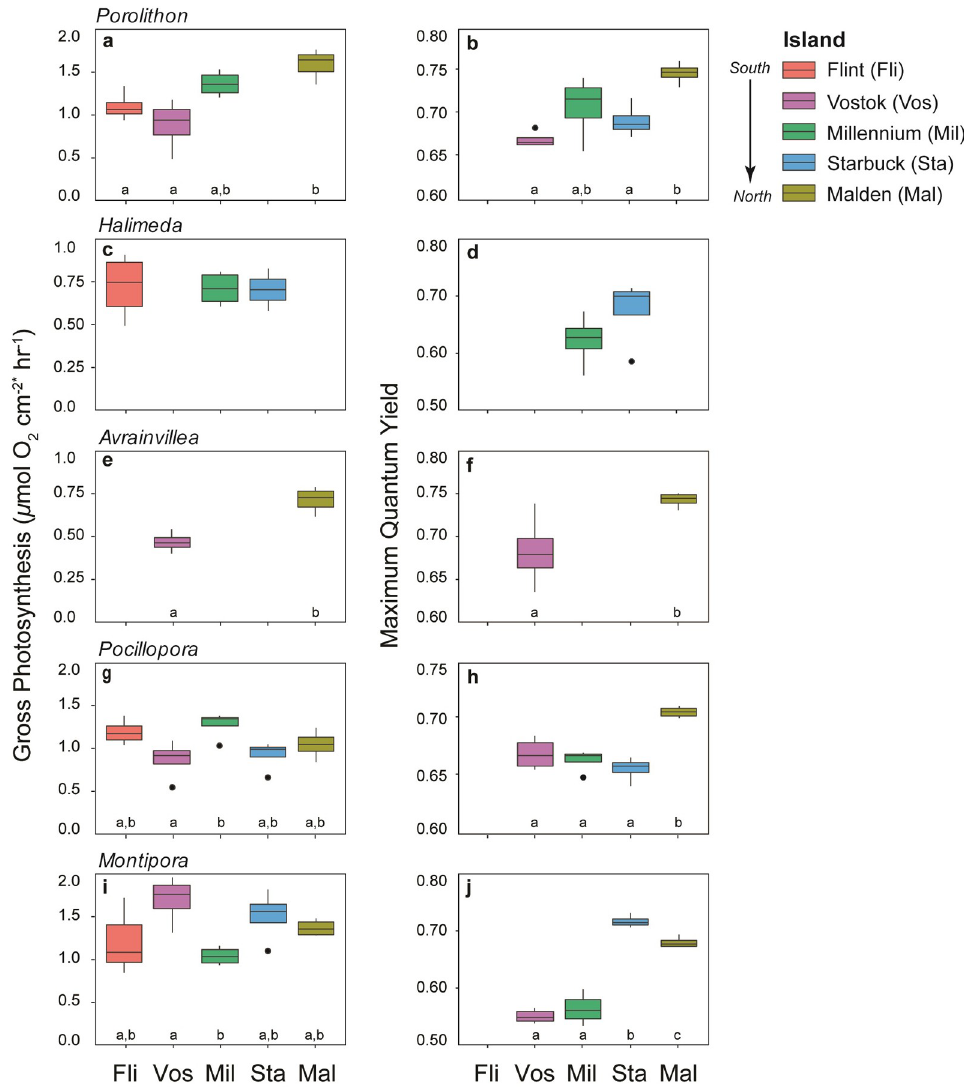
Fig 3. Coral and algal metabolism and photosynthetic efficiency. Box plots of gross photosynthesis and maximum quantum yield of (a-b) Porolithon sp., (c-d) Halimeda sp., (e-f) Avrainvillea amadelpha , (g-h) Pocillopora meandrina , and (i-j) Montipora aequituberculata . Islands are ordered from south to north across the x-axis (from left to right), and missing bars indicate where a given species was not present at an island. Due to logistical difficulties, there were no maximum quantum yield measurements at Flint or photosynthesis measurements from Porolithon at Starbuck. Significant differences between islands were determined by Tukey’s HSD, different letters represent significant differences at p < 0.05. Gross photosynthetic rates for Porolithon and corals were normalized to surface area, and are expressed as μ mol O 2 cm -2 hr -1 . � Rates for the algae, Halimeda and Avrainvillea , were normalized to fresh weight, thus for those taxa the units are μ mol O 2 mg -2 hr -1